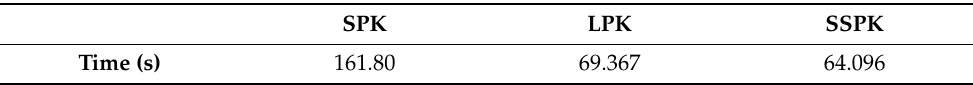
Table 2. Computational time for the first case